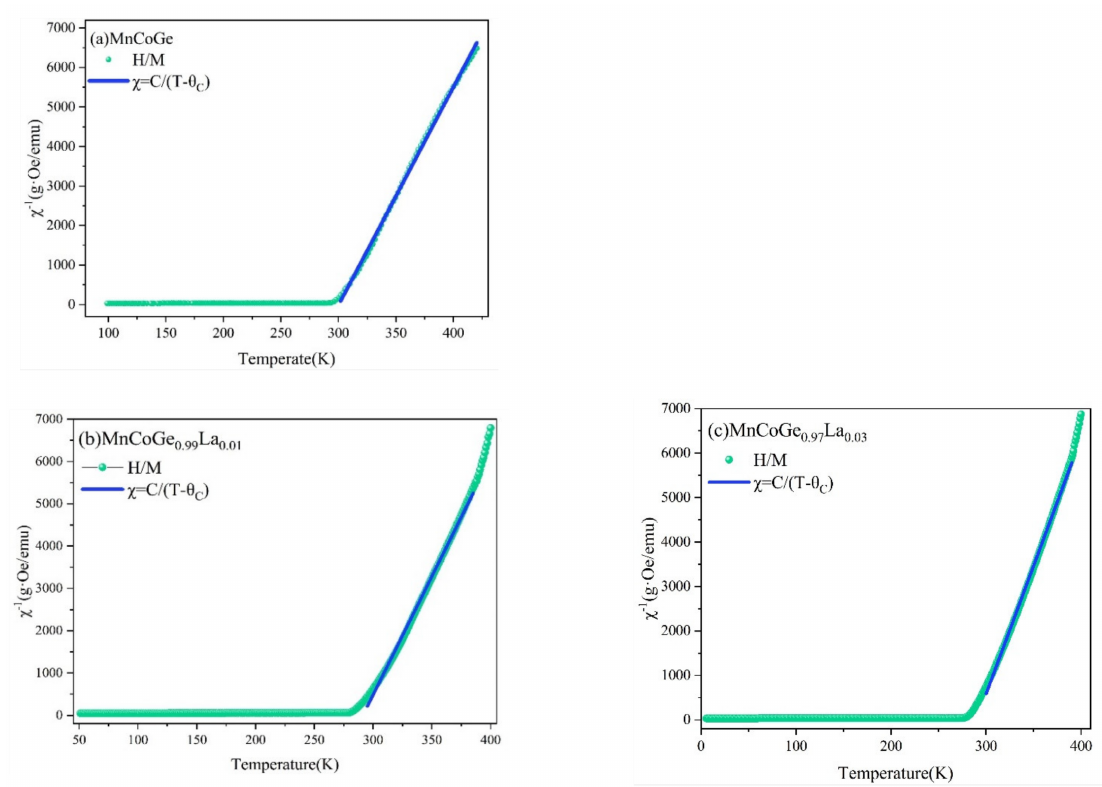
Figure 6. χ − 1 –T fitting curves of MnCoGe 1 − x La x : ( a ) MnCoGe; ( b ) MnCoGe 0.99 La 0.01 ; ( c ) MnCoGe 0.97 La 0.03 .